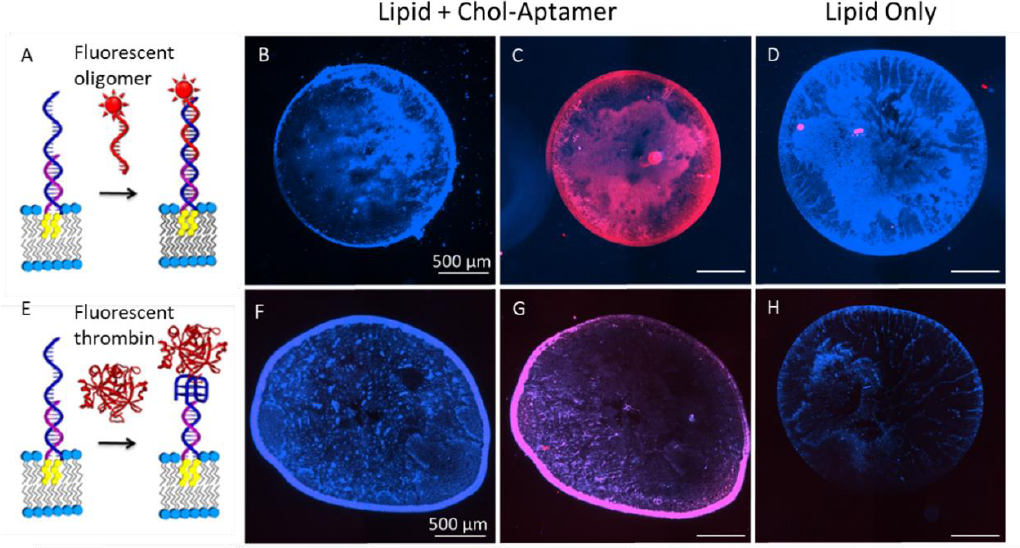
Figure 2. Aptamer functionalization of thick lipid droplets and binding of fluorescently labeled cDNA and aptamers. The lipids were fluorescently labeled blue in this experiment, and the analytes were labeled with a red fluorophore. The images show fluorescence overlays of both red and blue channels. ( A ) Schematic illustration of the use of a fluorescently labeled oligomer to detect the aptamer sequence. ( B , C ) Fluorescence images of a large (millimeter scale) aptamer functionalized lipid multilayer spot before ( B ) and after ( C ) exposure to the complementary oligomer fluoresced in red. ( D ) A lipid spot after exposure to the oligomer as a negative control. ( E – H ) The same experiment was carried, but with the oligomer replaced with the target of the aptamer; in this case the fluorescently labeled protein was thrombin.